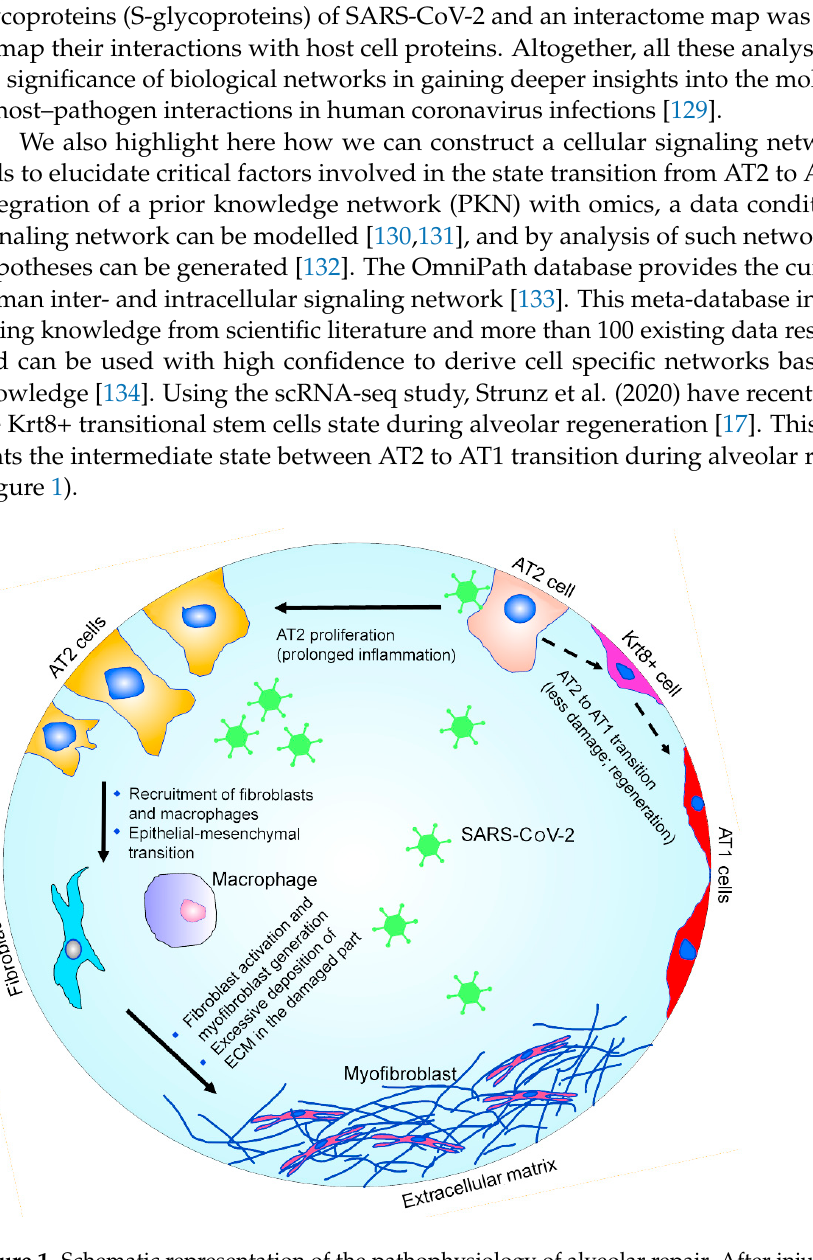
Figure 1. Schematic representation of the pathophysiology of alveolar repair. After injury, during the regeneration process, a subgroup of AT2 cells behave as progenitor cells and give rise to AT1 cells via an intermediate Krt8+ stage. The prolonged inflammation caused by the SARS-CoV-2 infection can trigger excessive fibrotic repair. The deposition of collagen and other extracellular matrix components during the excessive fibrotic repair plays a critical role in fibrosis.